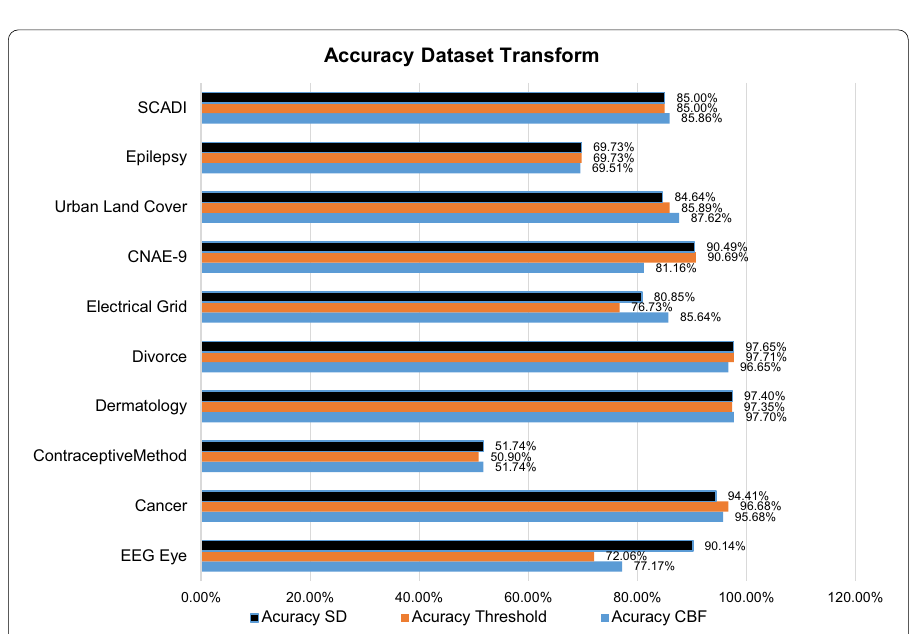
Fig. 4 Comparison for the mean value of transformation dataset